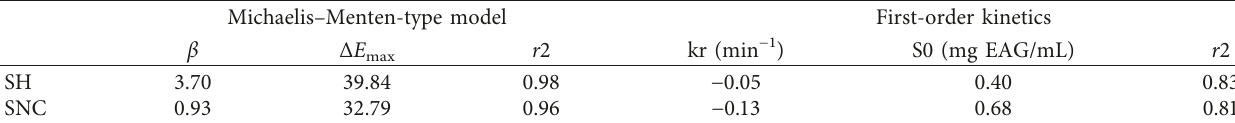
Table 5: Parameters obtained from the adjustment of Δ E curves to a Michaelis–Menten type and first-order kinetic model curves. Michaelis–Menten-type